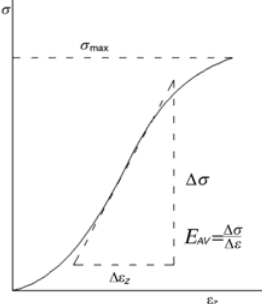
Figure 5: Method for calculating Young modulus from axial stress- axial strain curve; average modulus of linear portion of stress-strain